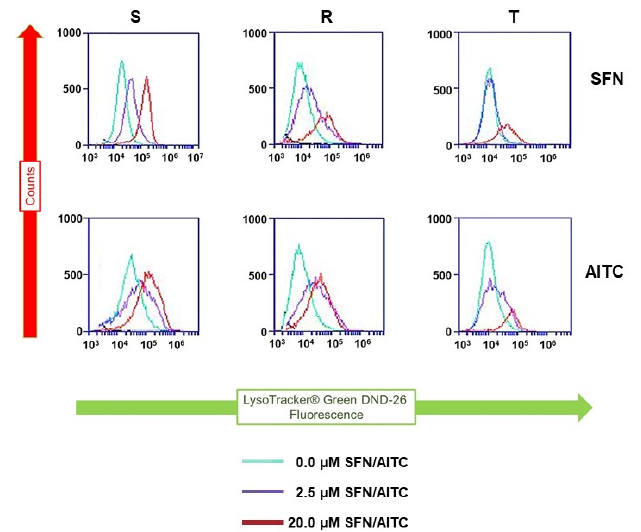
Figure 9. L1210 cell variants (S, R and T) were treated with SFN and AITC (at given concentrations) for 24 h and then stained with LTG. In the past, LTG has been shown to be useful for detecting the efflux activity of BCRP [37], which is an ABCG2 member of the ABC transporter family and is known to be associated with MDR. Although LTG has not yet been described as a P-gp substrate, we applied the P-gp inhibitor TQR at a concentration of 500 nM to maintain the conditions of the experiment documented in Figure 8. Data are representative of three independent measurements.